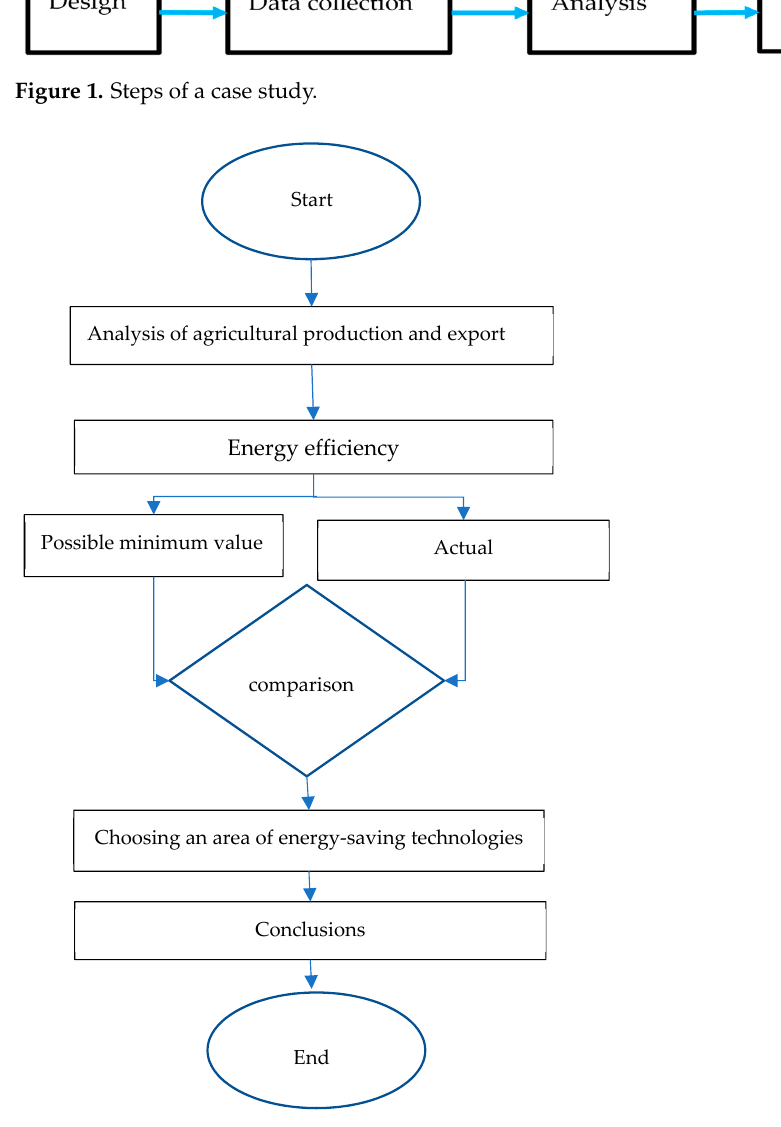
Figure 2. Flowchart of the research methodology. Energy efficiency is determined for road, railway, and IWT. To compare different kinds of transport, we used such indicators as specific energy consumption, traction effi ‐ ciency, and actual specific energy consumption. Railway, road, and IWT specific energy consumption are combined with tkm data, allowing the calculation of energy intensities for freight activity. Data from the specification of transport means (self ‐ propelled vessels, barges, tugs, and pushers) are taken to determine the energy indicators from the specifi ‐ cation. To find actual energy consumption, statistical yearbooks are used (carriage of goods and consumption of fuels). When transport companies do not report any energy consumption, we calculated this indicator using technical data of transport facilities. Ac ‐ tual specific energy consumption is the total energy consumption to the carriage of goods: ACGOEECAEC n i (1) where OE is the oil equivalent, OE = 41,800 kJ/kg; ACG is the carriage of goods tkm; EC i is the fuel consumption of i th kind, kg of oil equivalent. Theoretical minimum specific energy consumption (loaded voyage) is: